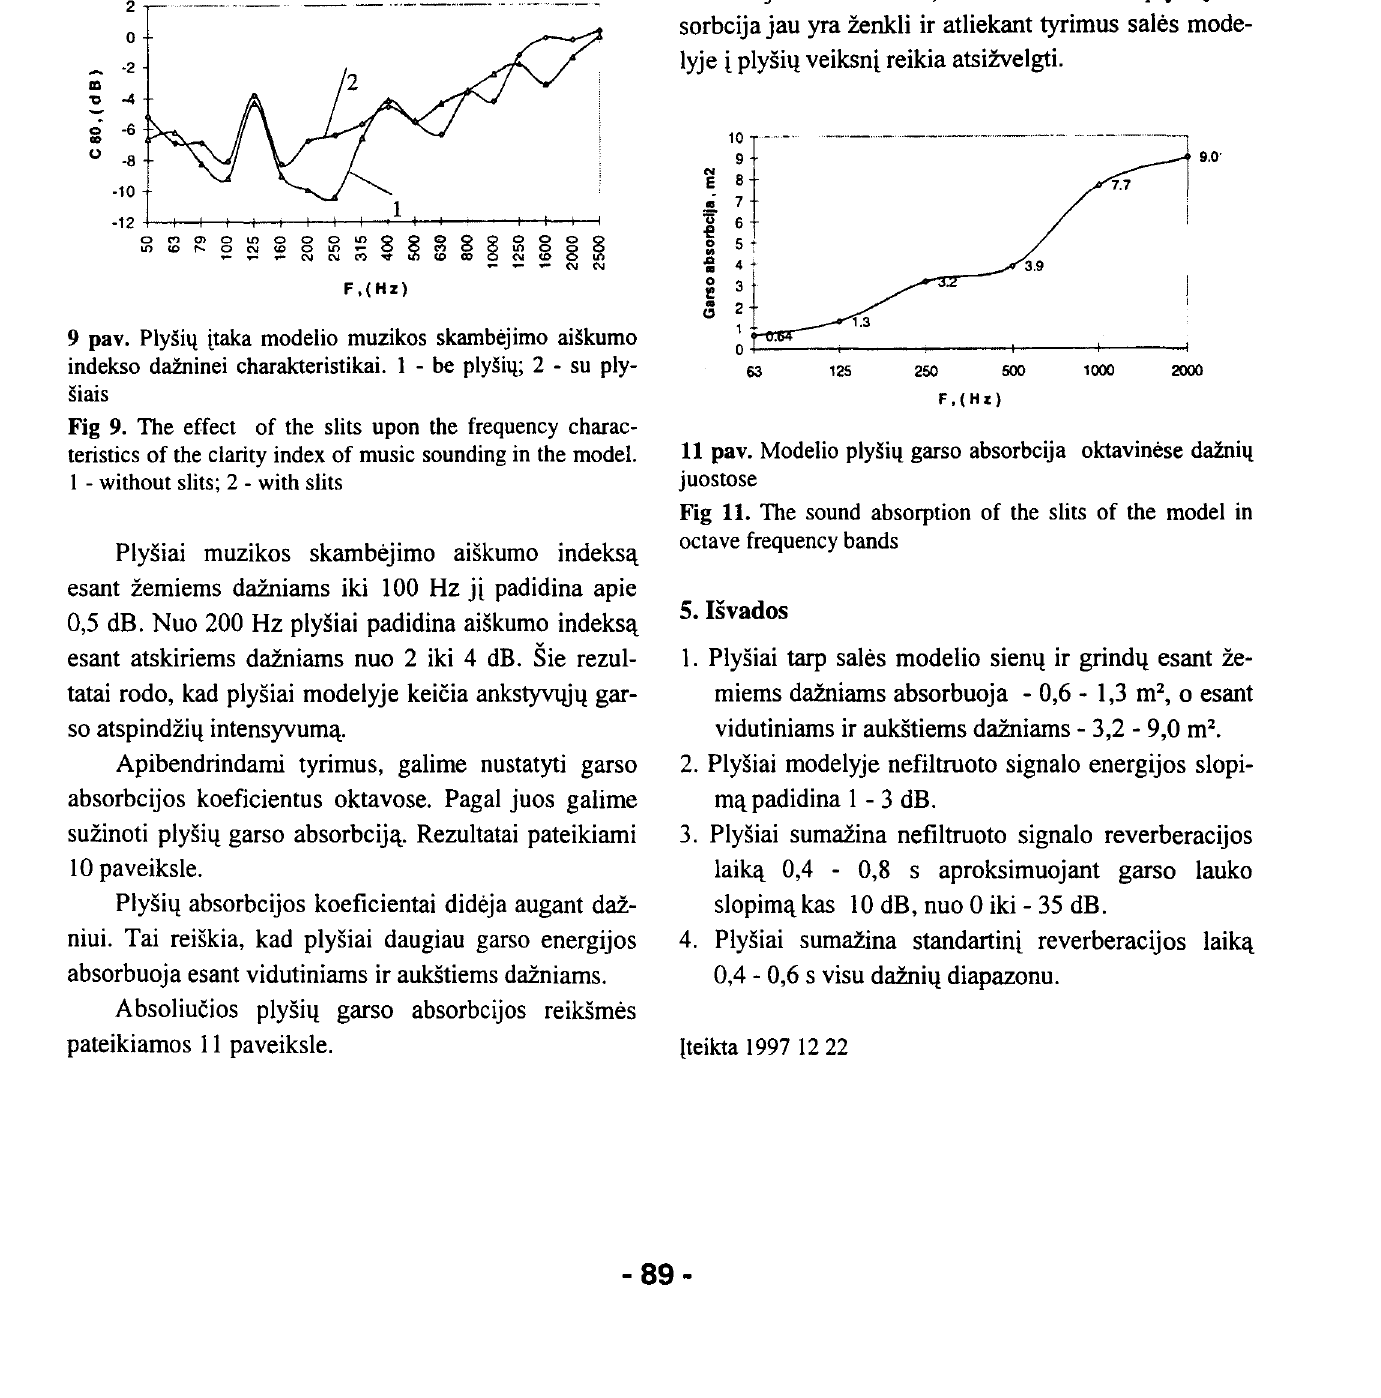
Fig 9. The effect of the slits upon the frequency charac teristics of the clarity index of music sounding in the model. 1 - without slits; 2 - with slits